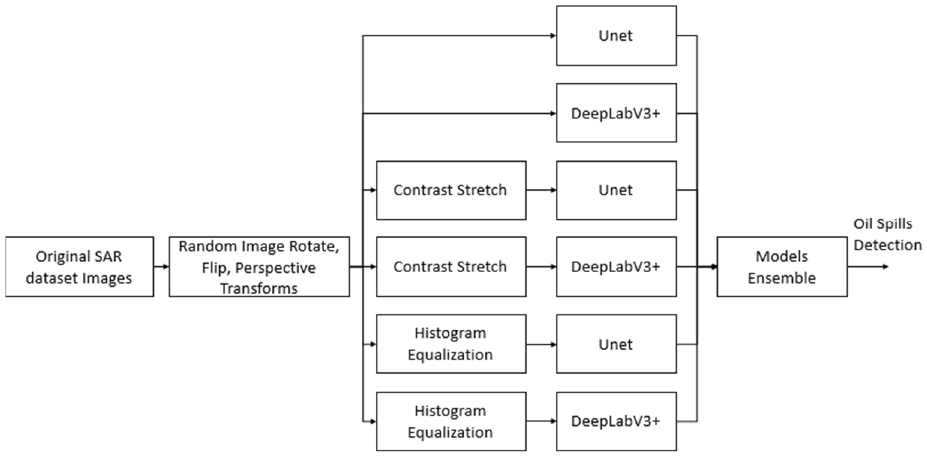
Figure 13. Oil Spill detection system—suggested sequence.